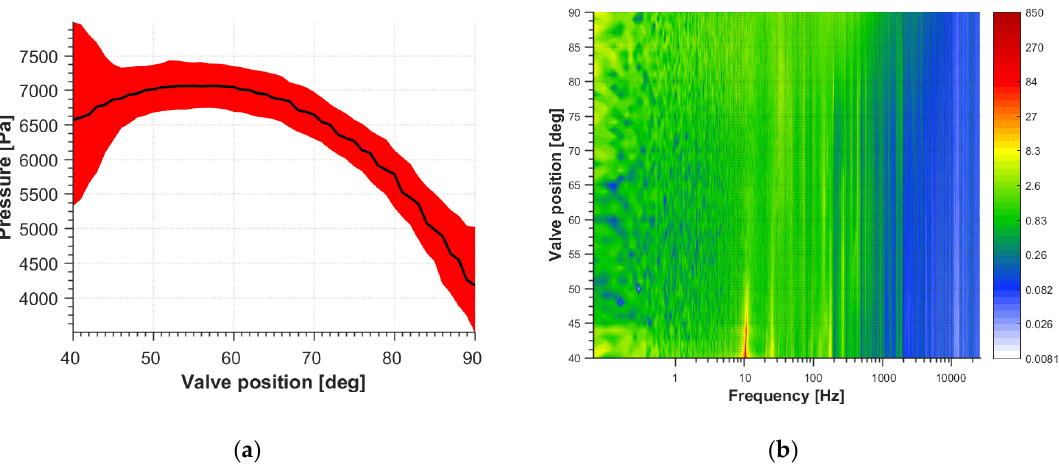
Figure 14. Pressure variation depending on the valve position measured at the diffuser at outlet rotational speed 120 Hz. ( a ) The left plot represents the min-to-max plot (red) and the pressure average value (black). ( b ) The right plot represents the spectral map with the colormap in the logarithmic scale.